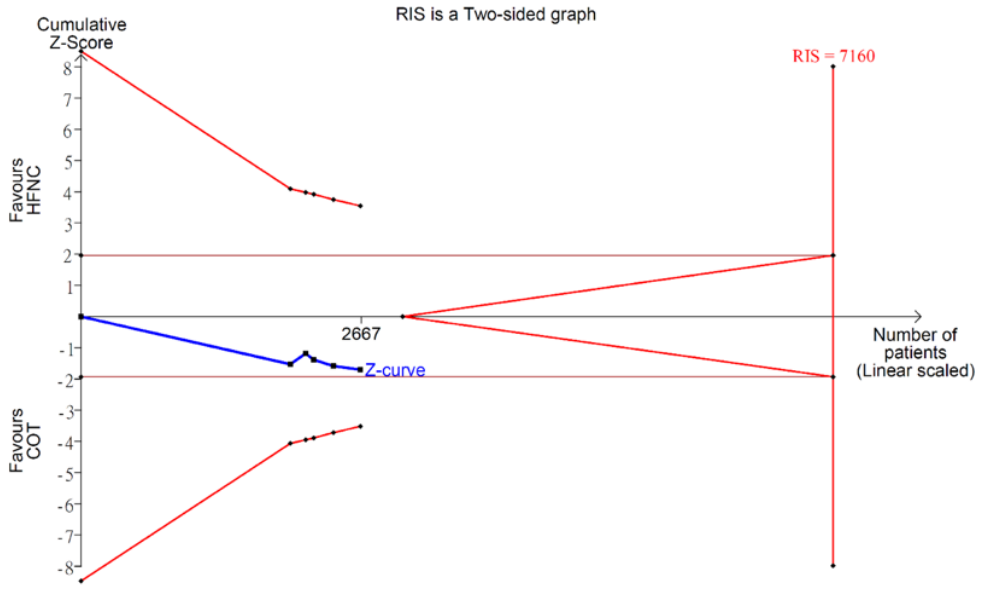
Figure A11. Bayesian random effect consistency model Outcome: Duration of procedure.